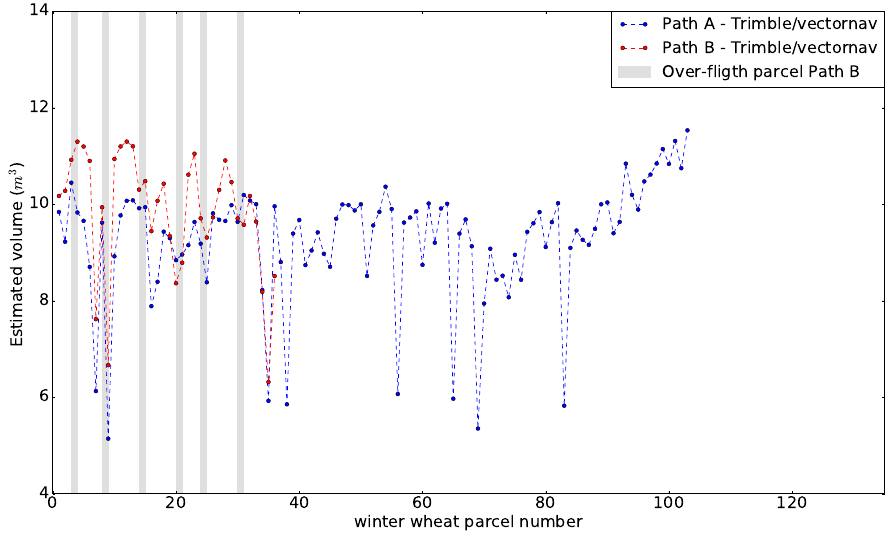
Figure 11. Volume estimates for flight paths A and B. The grey line marks the specific crop parcels that the UAV overflew when following Path